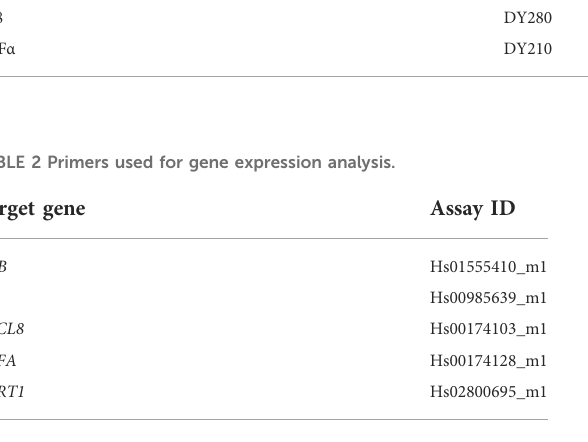
quanti fi cation in the medium.